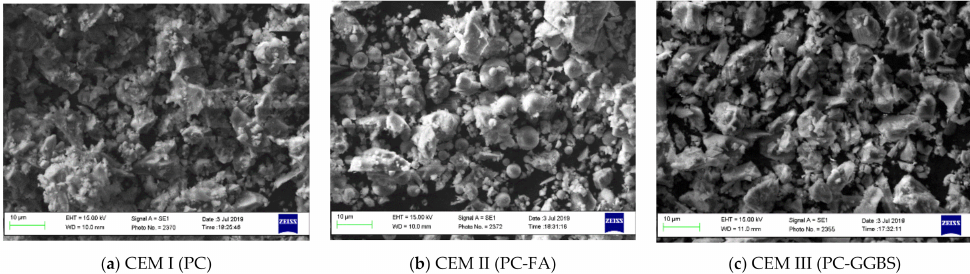
Figure 3. SEM micrographs of CEM I (PC) ( a ), CEM II (PC-FA) ( b ), and CEM III (PC-GGBS) ( c ). PC: Portland cement, FA: fly ash, GGBS: ground granulated blast-furnace